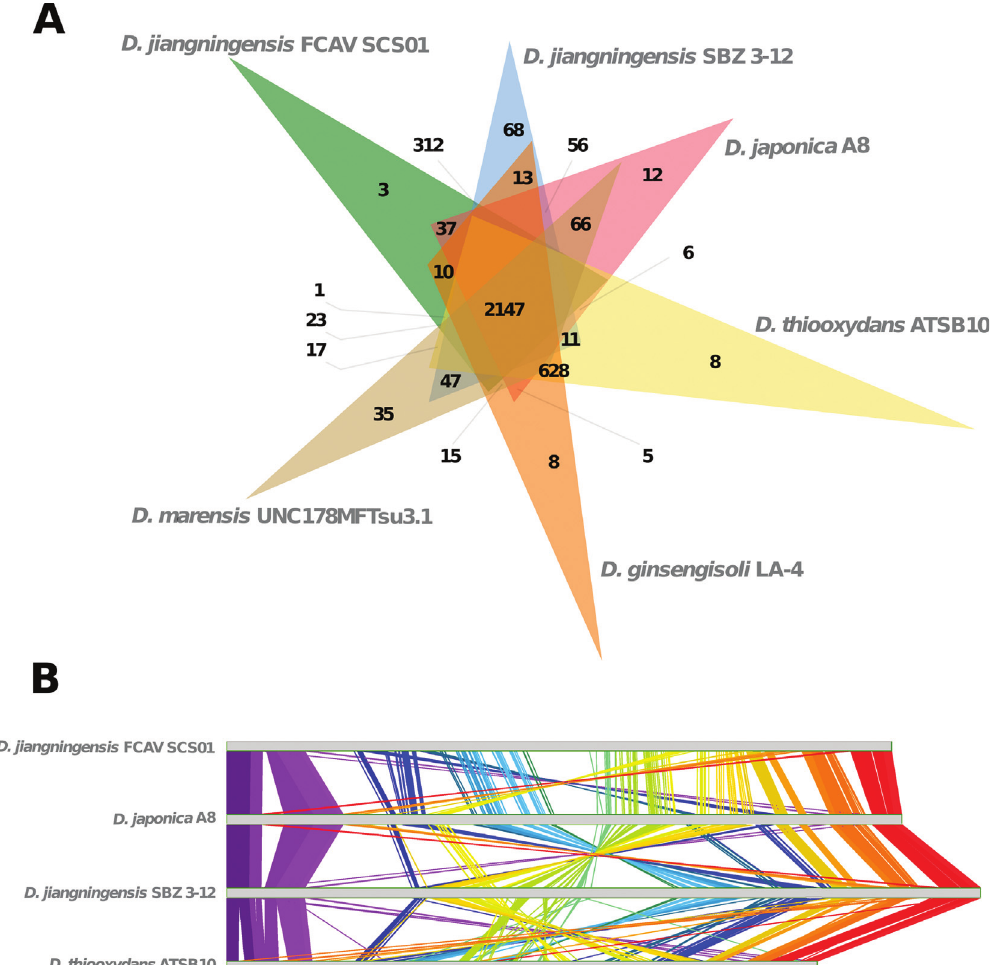
Figure 2 - Comparative genomics of Dyella jiangningensis FCAV SCS01 against other publicly available Dyella genomes. (A) Venn diagram showing shared orthologous clusters generated by OrthoVenn webservice (Wang et al. , 2015). The genus forms 5,029 clusters, 4,895 orthologous clusters (con- taining at least two species) and 1,951 single-copy gene clusters; (B) Syntenic regions between Dyella genomes generated by M-GCAT (Treangen and Messeguer 2006). For the alignment only complete genomes were considered (please refer to Table S1). The dnaA gene was used as starting point for the